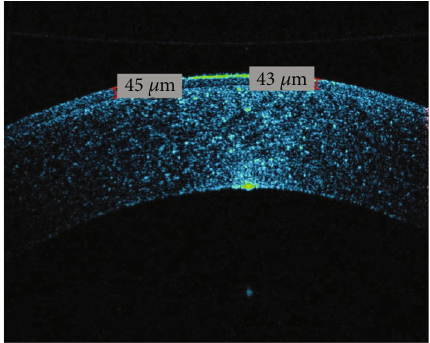
Figure 2: Preoperative AS-OCT of the left eye with corneal epithelium